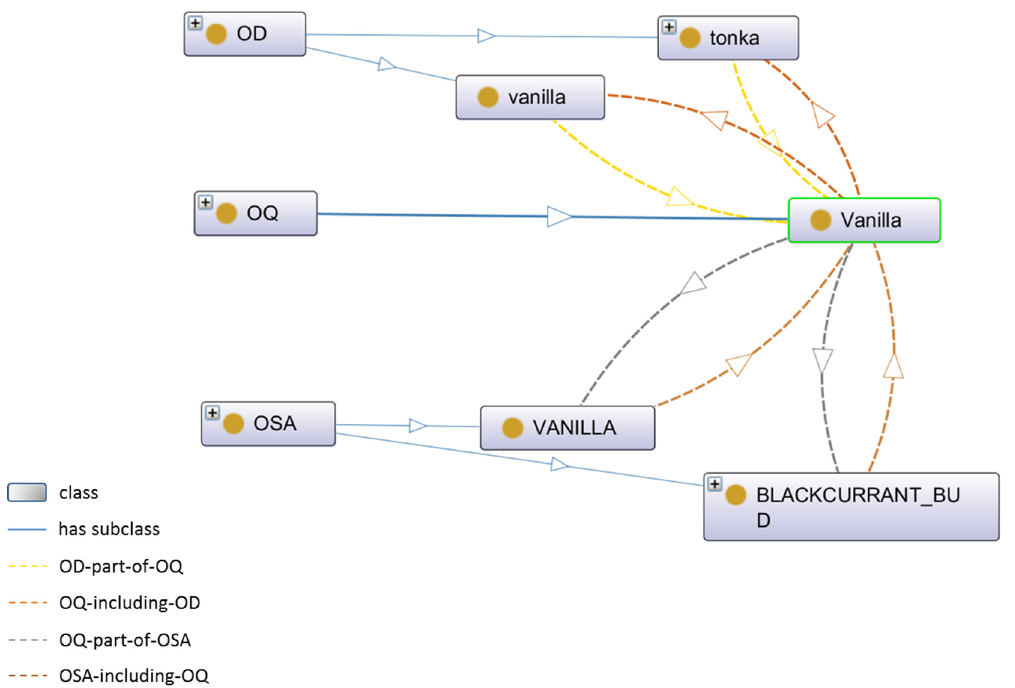
Figure 2. Properties and relationships among the classes OD, OQ, and OSA, considering the OQ “Vanilla”.